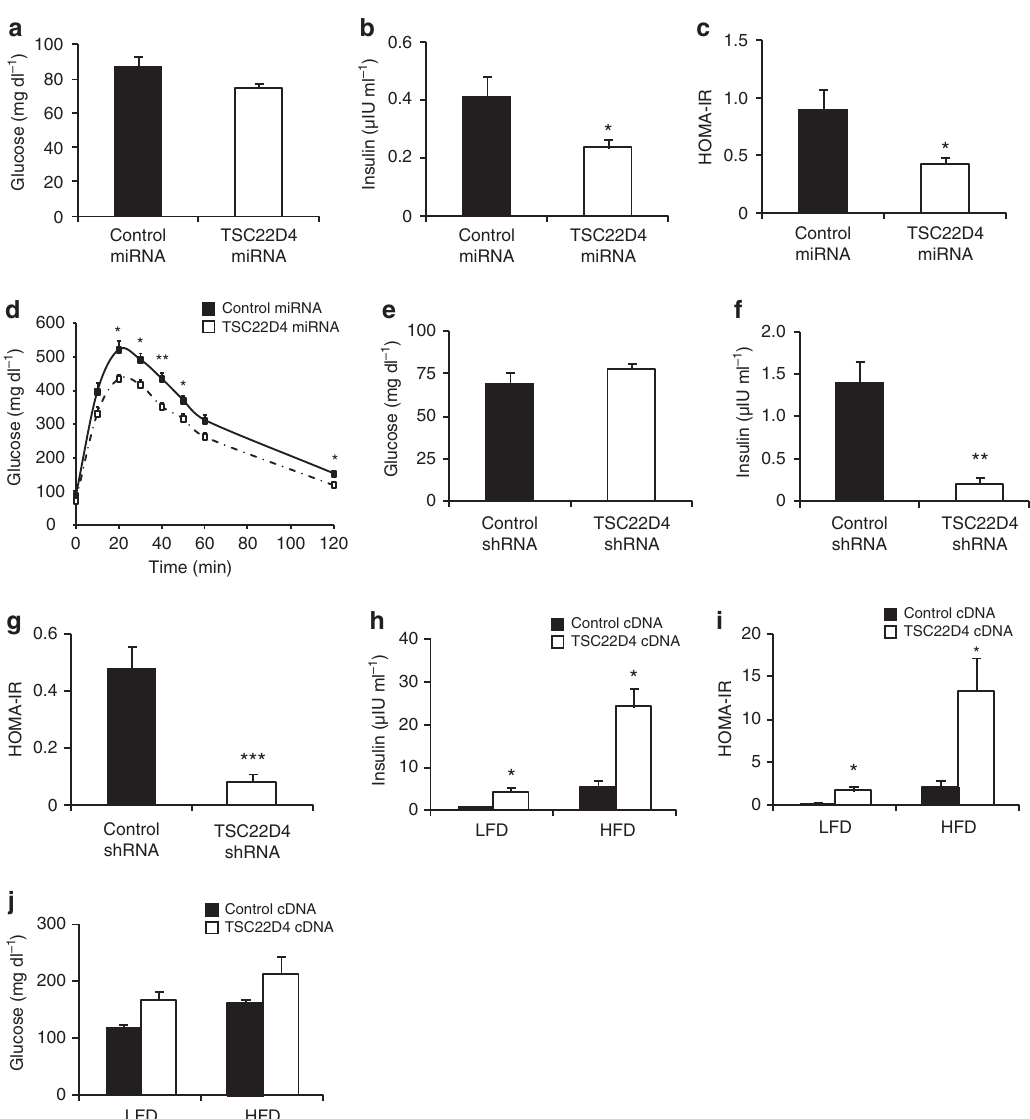
Figure 2 | TSC22D4 regulates systemic glucose homeostasis. ( a ) Serum glucose levels of 16h fasted control or TSC22D4 miRNA AAV–injected C57Bl/6 mice 6 weeks after virus injection (means ± s.e.m., n ¼ 5). ( b ) Serum insulin levels in same mice as in a . ( c ) HOMA-IR index of same mice as in a . ( d ) Glucose tolerance test in same mice as in a , 2 weeks after miRNA injection. Glucose was injected i.p. at a concentration of 1g glucose kg (cid:2) 1 body weight (means ± s.e.m., n Z 6). ( e ) Serum glucose levels of 16h fasted control or TSC22D4shRNA adenovirus–injected C57Bl/6 mice 7 days after virus injection (means ± s.e.m., n Z 6). ( f ) Serum insulin levels in same mice as in e . ( g ) HOMA-IR index in same mice as in e . ( h ) Serum insulin levels in empty control (control cDNA) or Flag- TSC22D4 (TSC22D4 cDNA) cDNA adenovirus-injected random fed C57Bl/6 mice that were fed either a LFD or HFD for 11 weeks (means ± s.e.m., n ¼ 5). ( i ) HOMA-IR index in same mice as in h . ( j ) Serum glucose levels in same mice as in h . Statistical analysis: Student’s t -test, * P r 0.05; ** P r 0.01; *** P r 0.001.